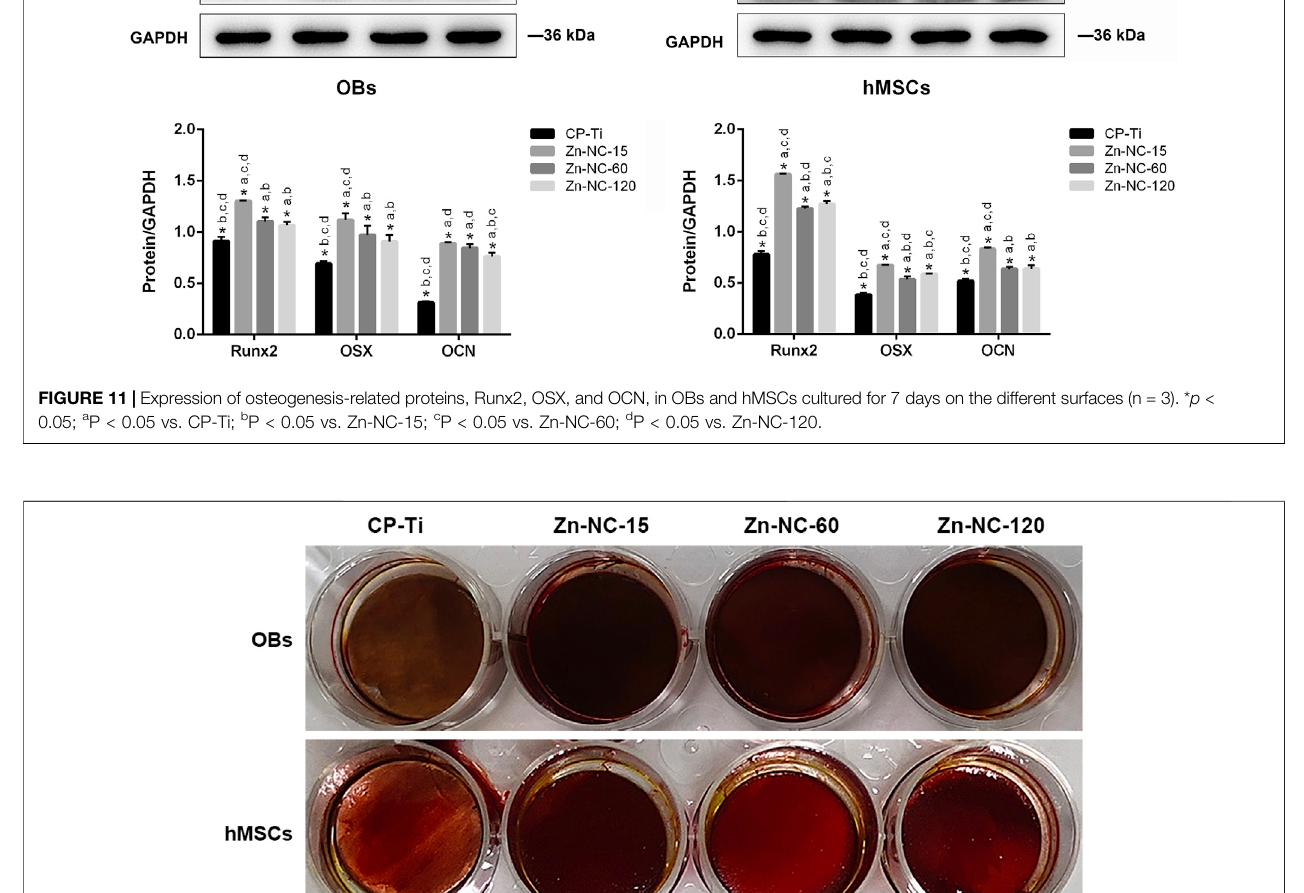
( Figure 2B ) of Zn 2p on Zn-NC-Ti specimens displayed a peak